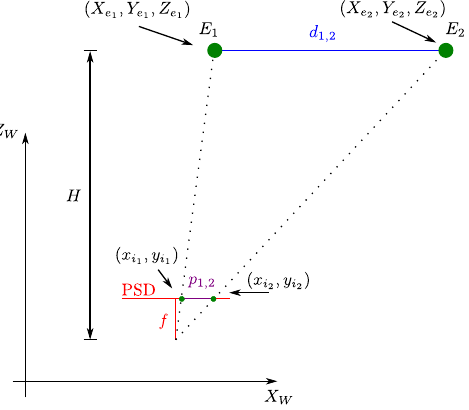
Figure 3. Triangulation method to obtaining the height H parameter.